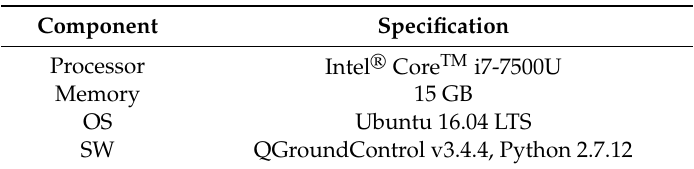
Table 5. Specifications of the GCS.